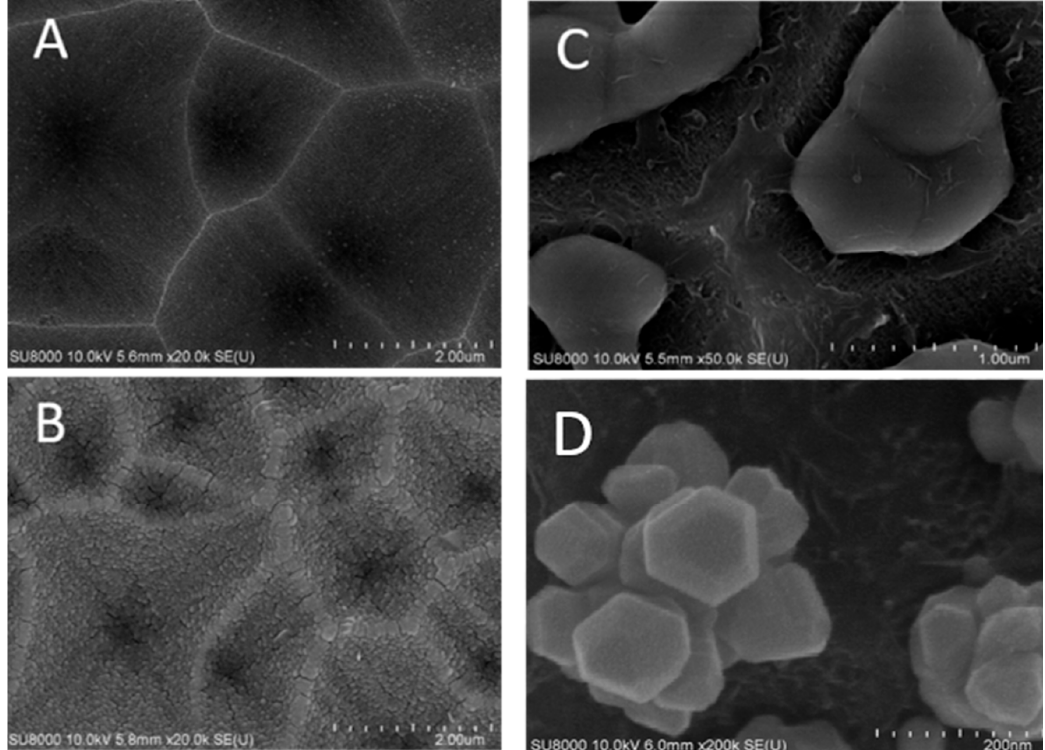
Figure 4. SEM images of ( A ) etched holes in a silicon wafer; ( B ) copper thin films on surfaces of etched holes; ( C ) solidified three-dimensional copper bumps inside holes etched into the silicon wafer; ( D ) clusters of silver nanoparticles grown in varied orientations by silver nitrate reduction on copper surfaces which are partially covered by graphene nano-islands synthesized by rapid thermal CVD.